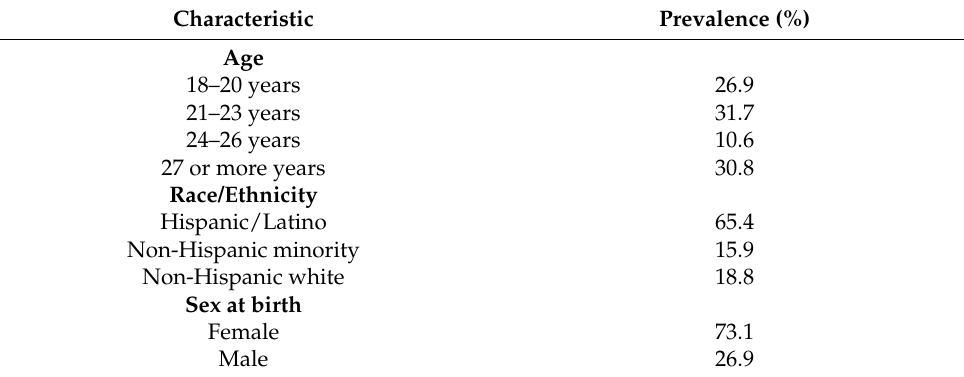
Table 1. Study population characteristics, n = 223.